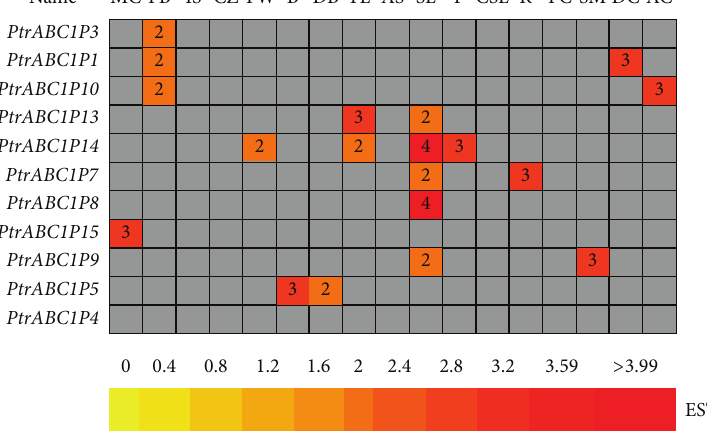
Figure 5: In silico EST analysis of P. trichocarpa ABC1 genes. The EST frequency for each gene was calculated by evaluating its EST representation among 17 cDNA libraries available at PopGenIE (http://www.popgenie.org/) [21]. The heatmap was visualized using the Heatmapper Plus tool by counting the corresponding ESTs for each particular gene in the database. The color bar at the bottom represents the frequencies of the EST counts. MC: male catkins, FB: flower buds, IS: imbibed seeds, CZ: cambial zone, TW: tension wood, B: bark, DB: dormant buds, YL: young leaves, AS: apical shoot, SL: senescing leaves, P: petioles, CSL: cold stressed leaves, R: roots, FC: female catkins, SM: shoot meristem, DC: dormant cambium, and AC: active cambium.